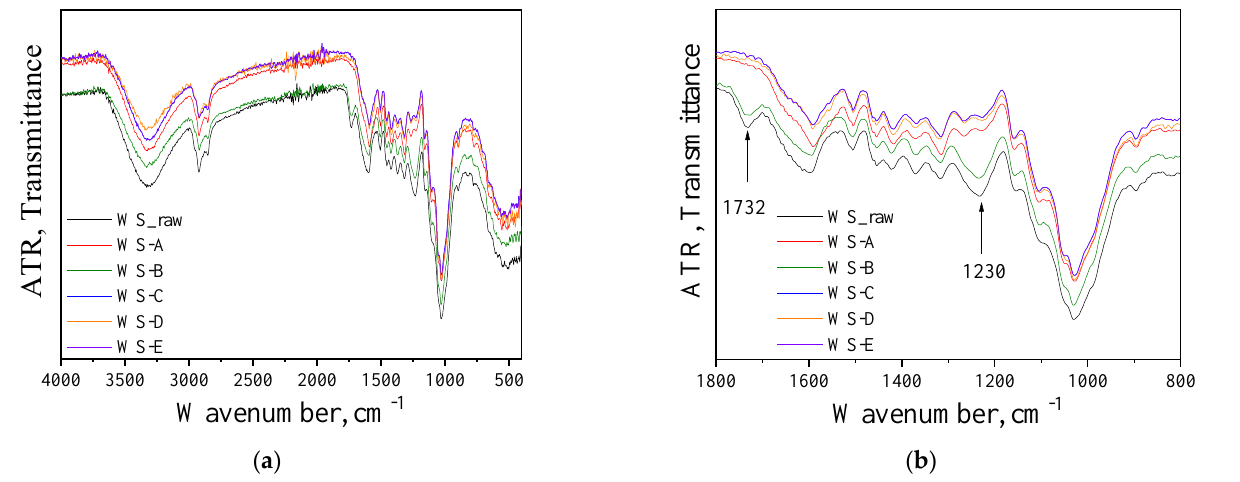
Figure 3. ( a ) FTIR-ATR spectra in the whole range and ( b ) in the fingerprint region between 1800 and 800 cm −1 for raw and WS samples after pretreatment approaches with (A) NaOH (0.5% w / v ), (B) H 2 O 2 (0.5% v / v ), (C) mixture of NaOH (0.5% w / v ) and H 2 O 2 (0.5% v / v ) at ratio 1:1, (D) initially NaOH (0.5% w / v ) followed by H 2 O 2 (0.5% v / v ), and (E) initially H 2 O 2 (0.5% v / v ) followed by NaOH (0.5% w / v ).